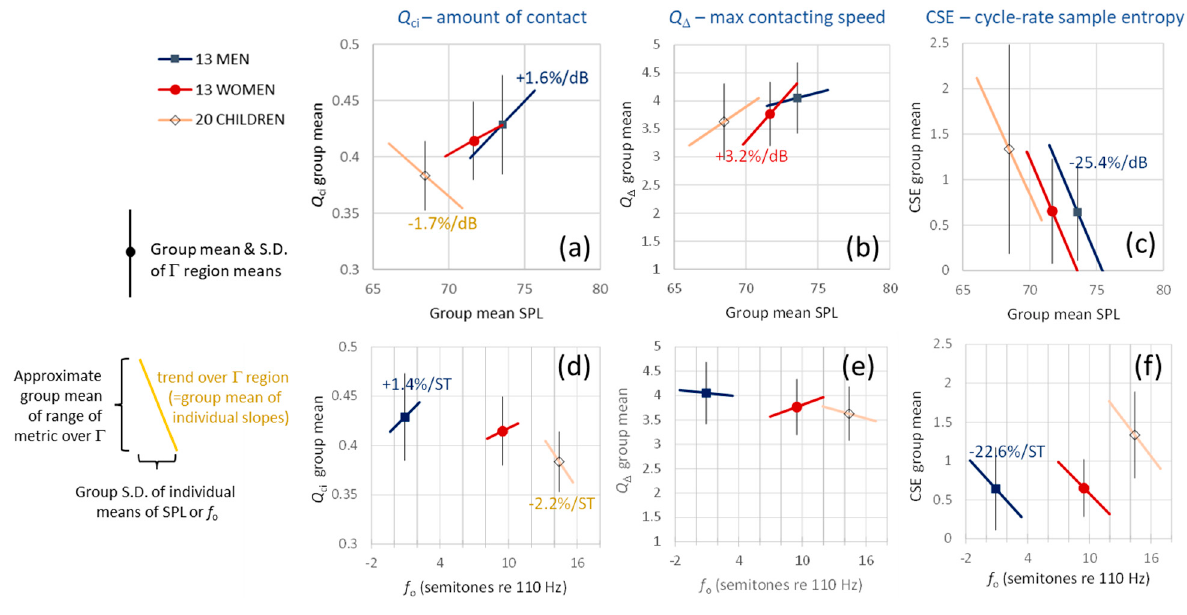
Figure 10. Gradients and other group-level statistics of three EGG metrics Q ci , Q ∆ and CSE, from VRPs on sustained /a:/, but evaluated only for the small Γ region that was derived from connected speech. Three groups of vocally healthy participants are represented: ■ men , ● women , ◊ children. The marker locations represent the group means. Each sloping line represents the gradient across Γ , averaged within the group. ( a – c ) gradients versus SPL (C-weighted, re. 20 µPa @ 30 cm); ( d – f ) gradients versus f o (semitones re. 110 Hz). (Previously unpublished data, collected for [18].)